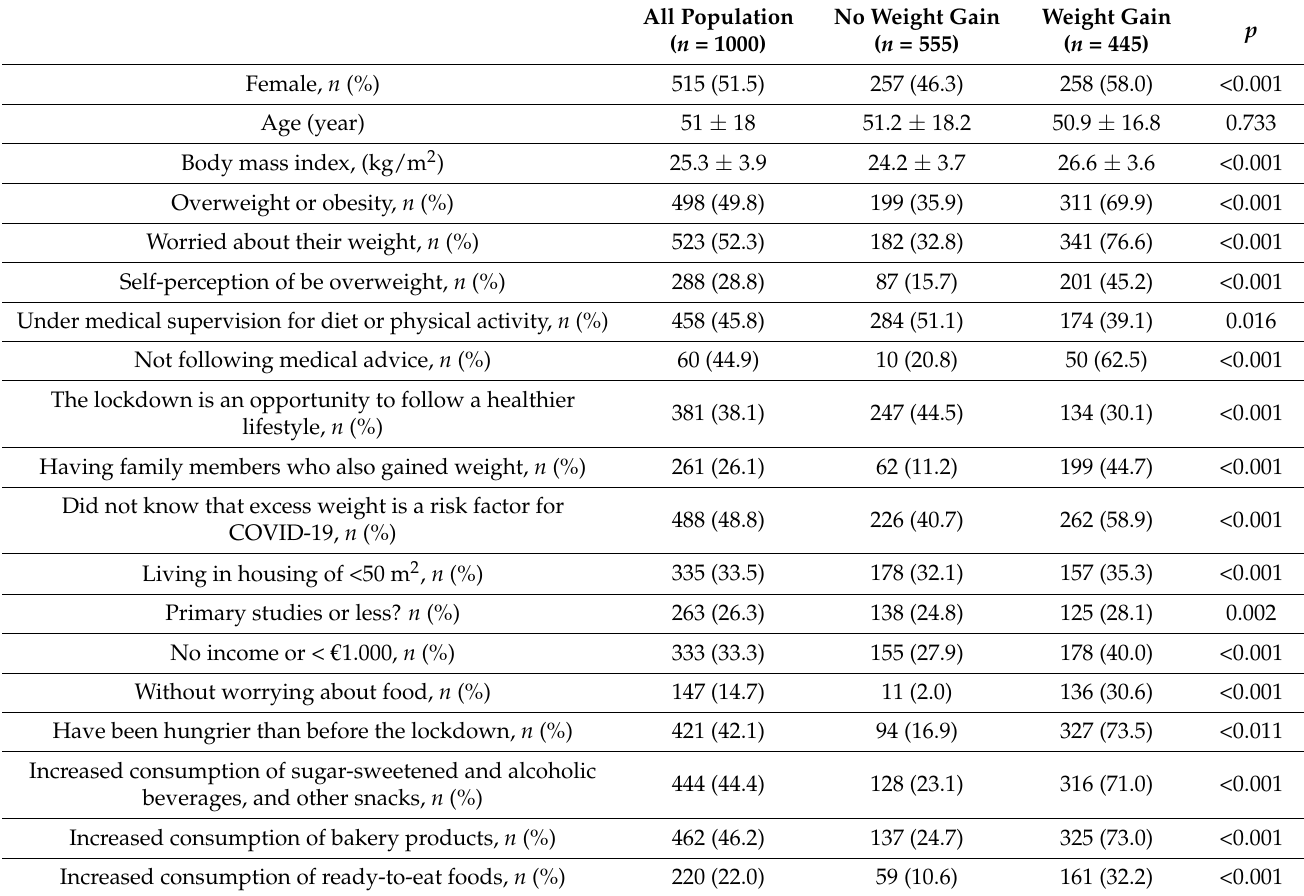
Table 2. Interview results regarding the main attitudes held the lockdown period according to weight progression. All